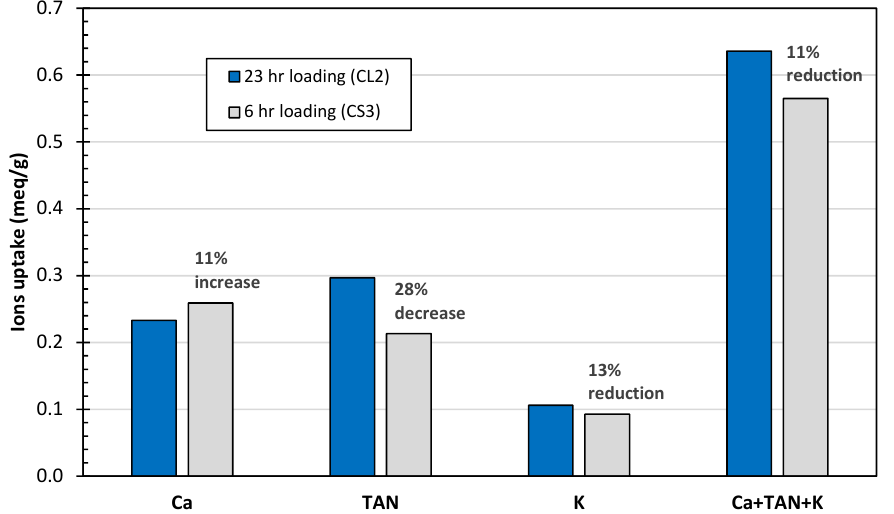
Figure 4. Cumulative ion uptakes at the end of the 23 h and 6 h loading cycles with NaOCl regen- eration.